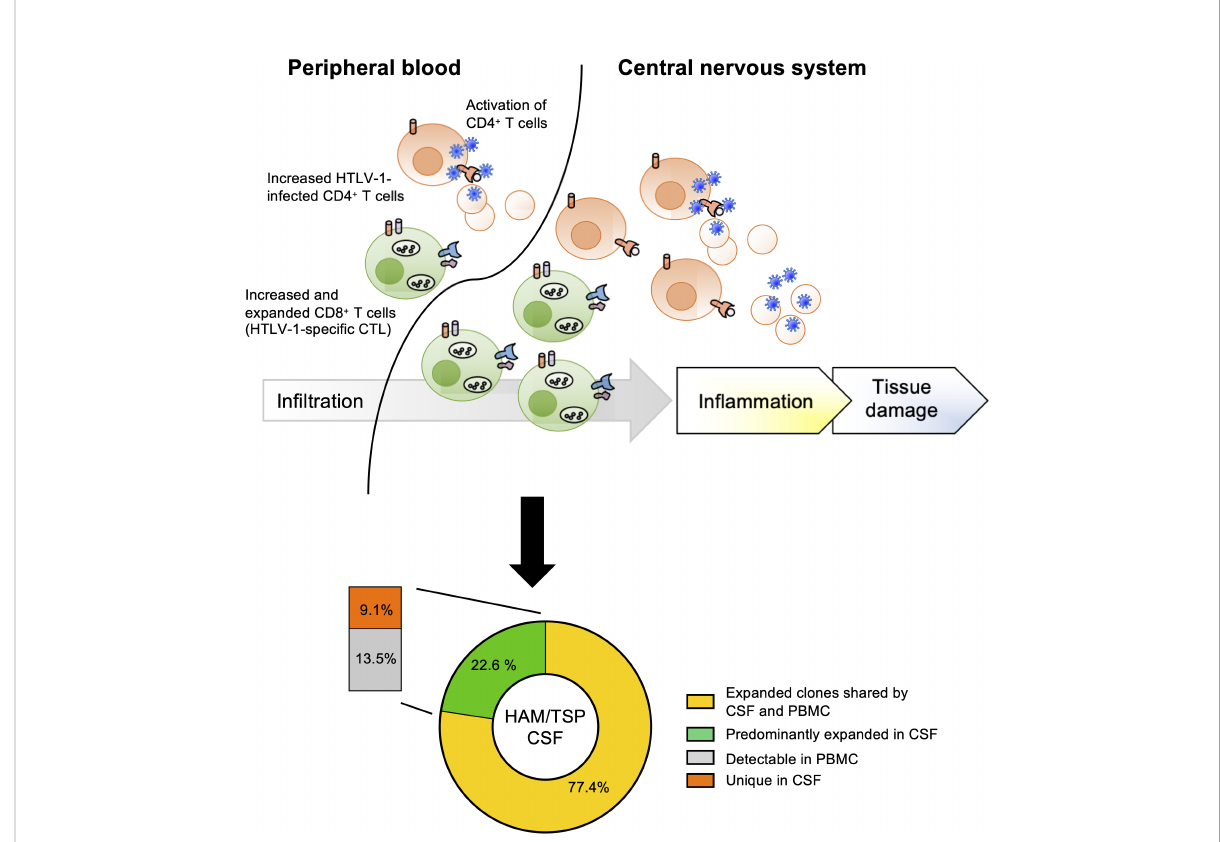
FIGURE 2 Origin of TCR expanded clones in CSF of HAM/TSP patients. HAM/TSP patients had a higher clonal T cell expansion, especially CD8 + T cells (including HTLV-1-speci fi c CTL), in PBMCs as well as in CSF. Within expanded T cell clones in CSF of HAM/TSP patients, most expanded CSF TCR- b clonotypes were derived from expanded T cell clones in PBMCs (yellow). A small but distinct fraction of these expanded TCR- b clonotypes were intrathecally enriched in CSF of HAM/TSP patients [reference